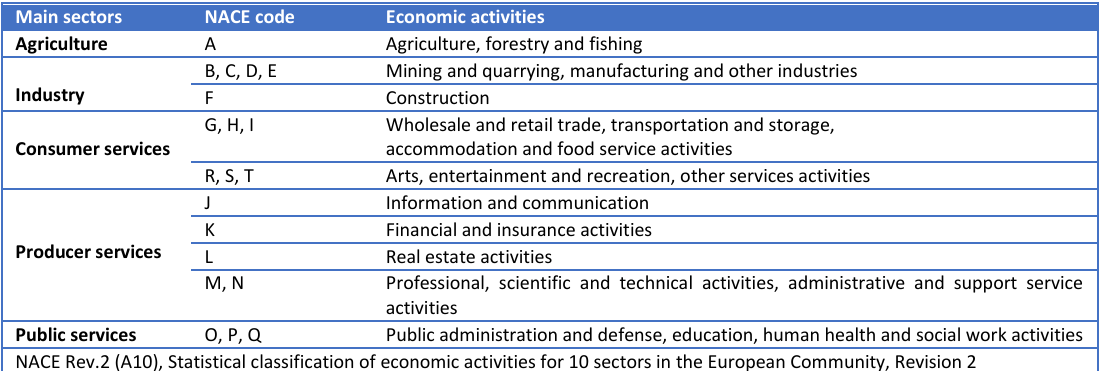
Table 2 Distribution of economic activities by